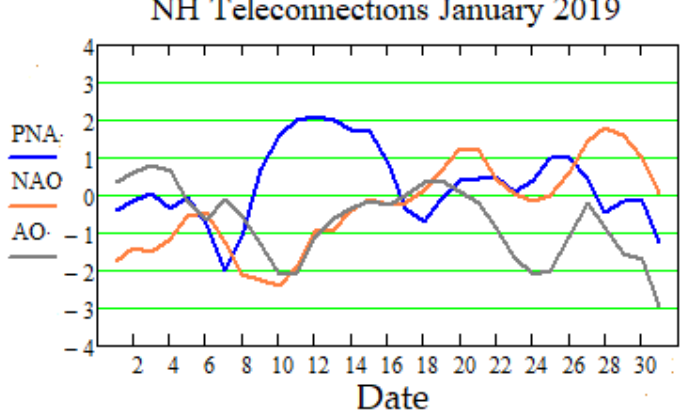
Figure 2. As in Figure 1, except for the time series of the Pacific North American Index (blue, solid), North Atlantic Oscillation (orange, solid), and Arctic Oscillation (gray, solid).